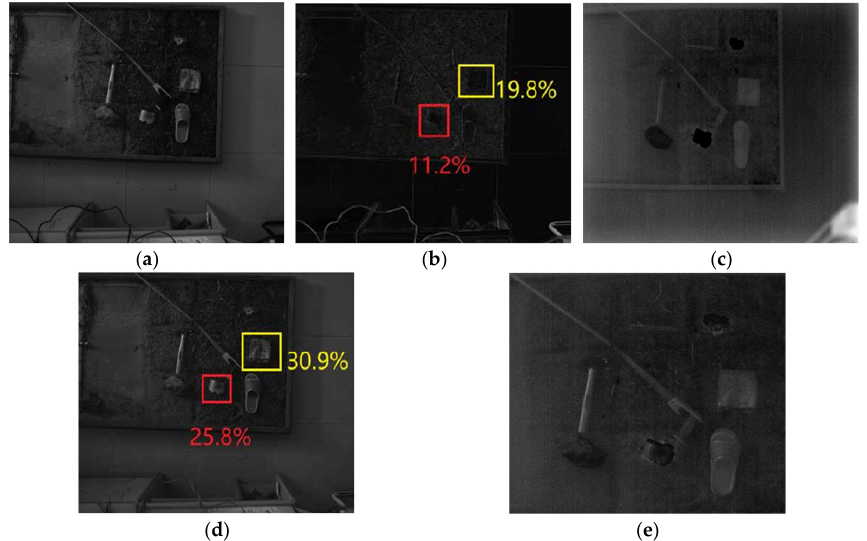
Figure 7. Intensity, polarization, infrared, and fusion images under natural light. ( a ) intensity image; ( b ) DoLP image; ( c ) Infrared image; ( d ) Intensity Polarization Fusion Image; ( e ) Intensity, polarization, and infrared fusion images.